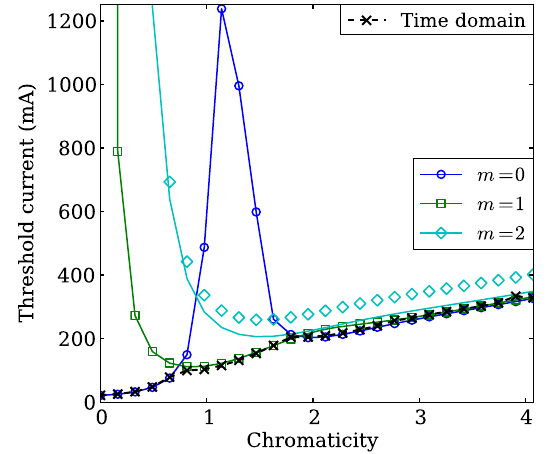
FIG. 15. Threshold current for the coupled-bunch resistive-wall for m instability for the case with a Gaussian bunch at an intermediate length of 100 ps. Results of macroparticle simulations in the time ; 0 Þ . mp domain (dashed line) are compared with those obtained using a frequency domain computation (solid lines).